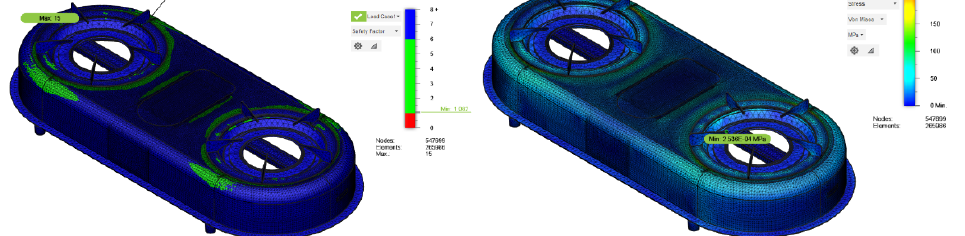
Figure 9. DFA analysis total for product redesign.